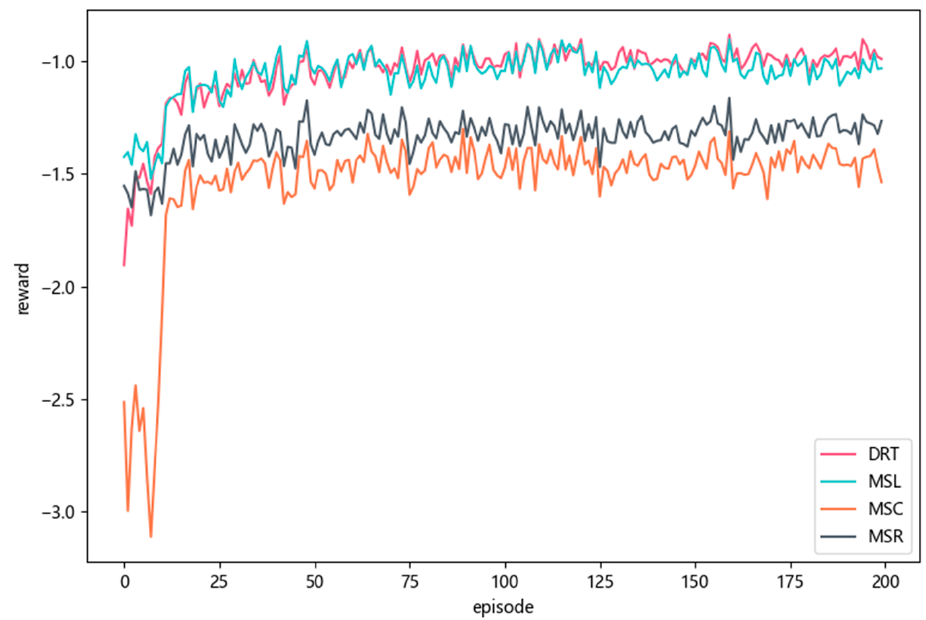
Figure 6. Comparison of reward with different strategies on MEC servers during training. Table 4. Average task execution delay compared with baseline strategies ( × 10 − 3